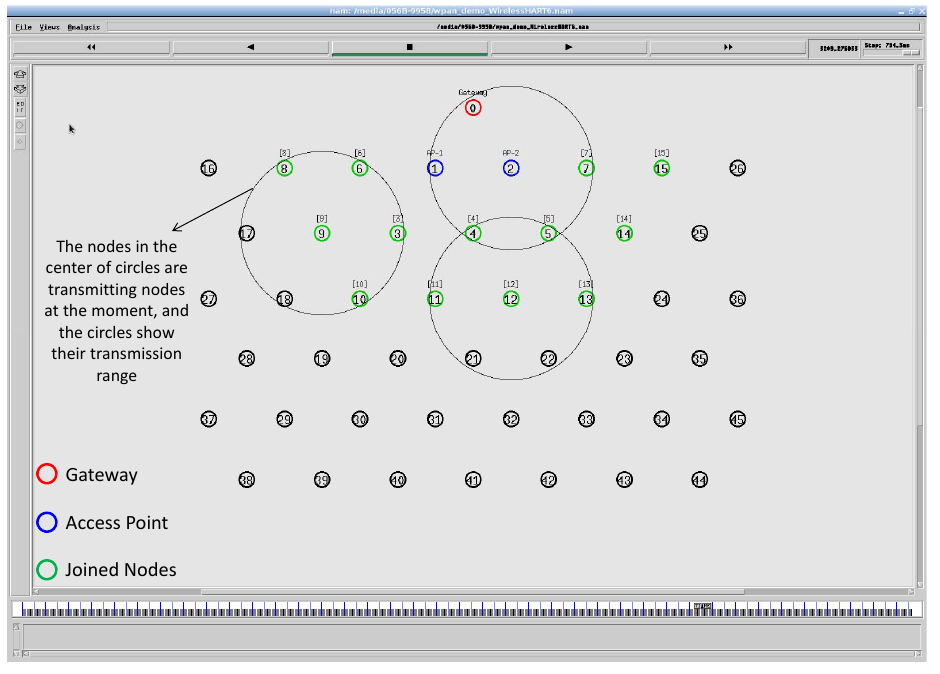
Figure 21. A sample multi-hop mesh network topology in the NS-2